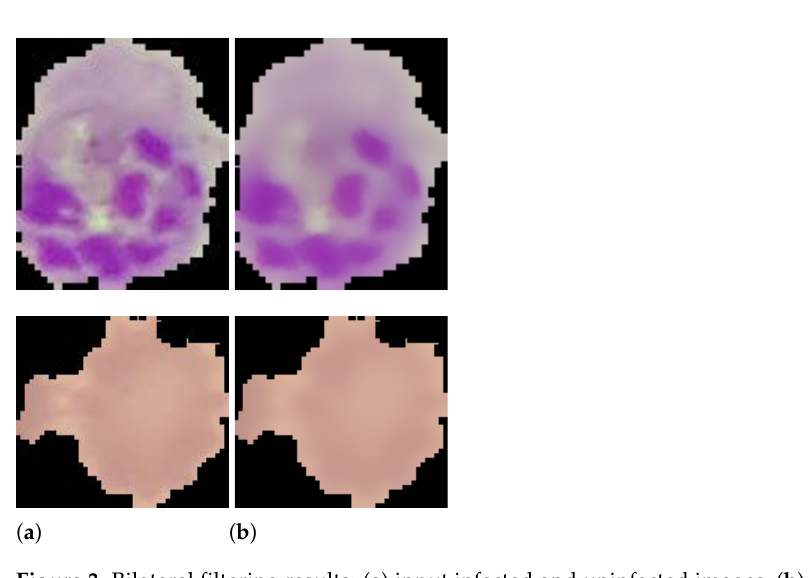
Figure 3. Bilateral filtering results: ( a ) input infected and uninfected images, ( b ) results of applying bilateral filtering on ( a ).